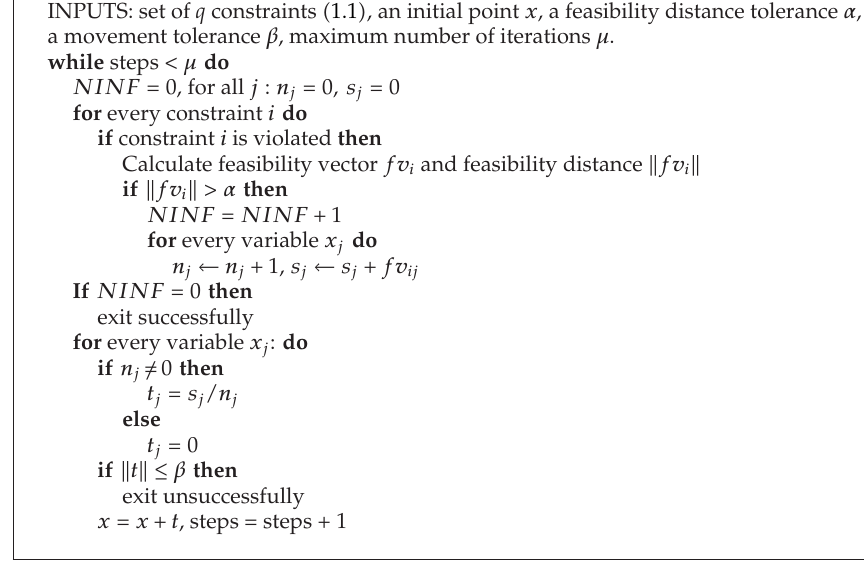
Algorithm 1: Original constraint consensus